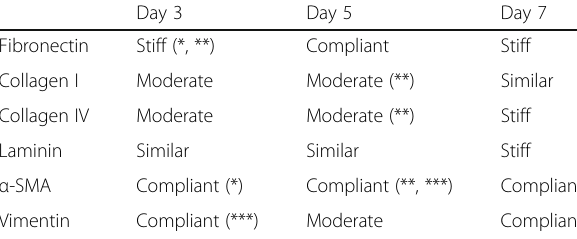
Table 2 Summary of protein expression results assessed between hydrogel conditions. Day 3: fibronectin expression was significantly higher for HMFs encapsulated in stiff as compared to compliant and moderate hydrogels. Collagens I and IV were more highly expressed for HMFs encapsulated in moderate as compared to compliant and stiff hydrogels. α -SMA and vimentin expression were significantly higher for HMFs encapsulated in compliant as compared to moderate and stiff hydrogels. Laminin expression was similar between the hydrogel conditions. Day 5: fibronectin expression was higher and α -SMA was significantly higher for HMFs encapsulated in compliant as opposed to moderate and stiff hydrogels. Collagens I and IV were significantly higher while vimentin was higher for HMFs encapsulated in moderate hydrogels as compared to compliant and stiff hydrogels. Laminin expression was similar between the hydrogel conditions. Day 7: fibronectin, collagen IV and laminin expression was